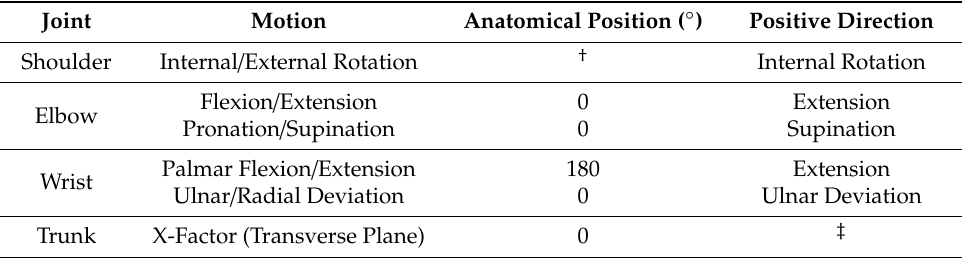
Table 1. Calculated joint angles, with their relative zero positions and positive directions. Joint Motion Anatomical Position ( ◦ ) Positive